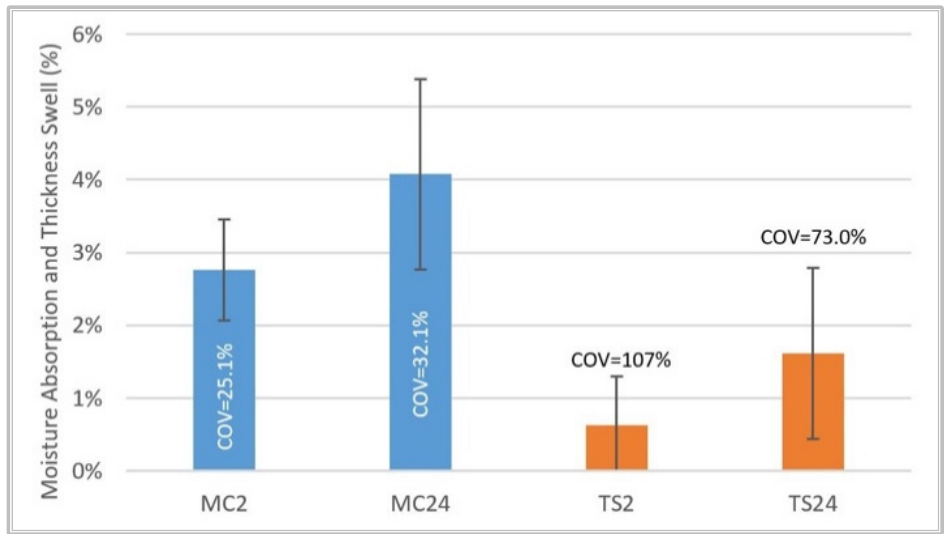
Figure 11. Moisture absorption and thickness swell properties of CRTM panels (MC2 and TS2 refer